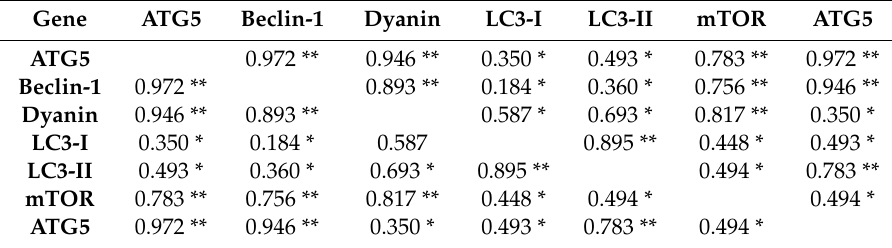
Table 7. Correlation analysis of autophagy-related-genes in the kidney of